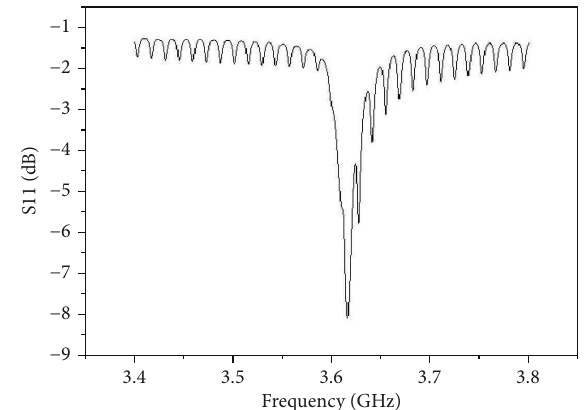
Figure 9: Te resonance frequency fgure of the AlN-based FBAR sensor after adding acetone, the horizontal axis is frequency while the vertical axis is S 11